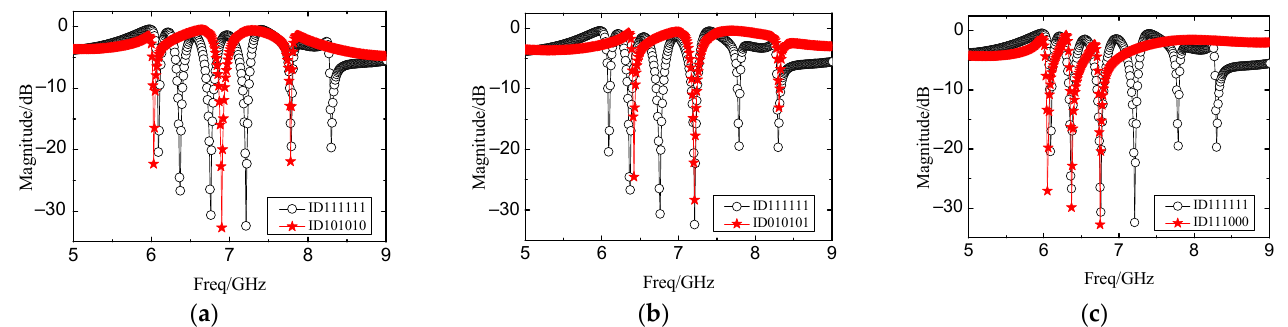
Figure 8. The simulation removed the resonance curves of the 6-bits U-shaped slot resonator chipless tags with a logic state of “0”: ( a ) ID111111 and ID101010; ( b ) ID111111 and ID010101;( c ) ID111111 and ID111000.